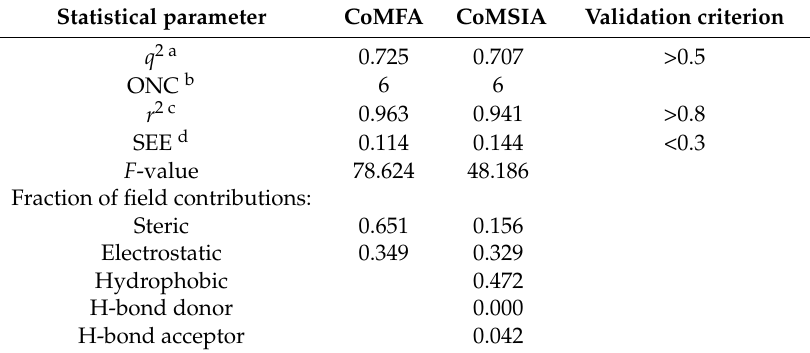
Table 10. Statistical parameters for the CoMFA and CoMSIA models.